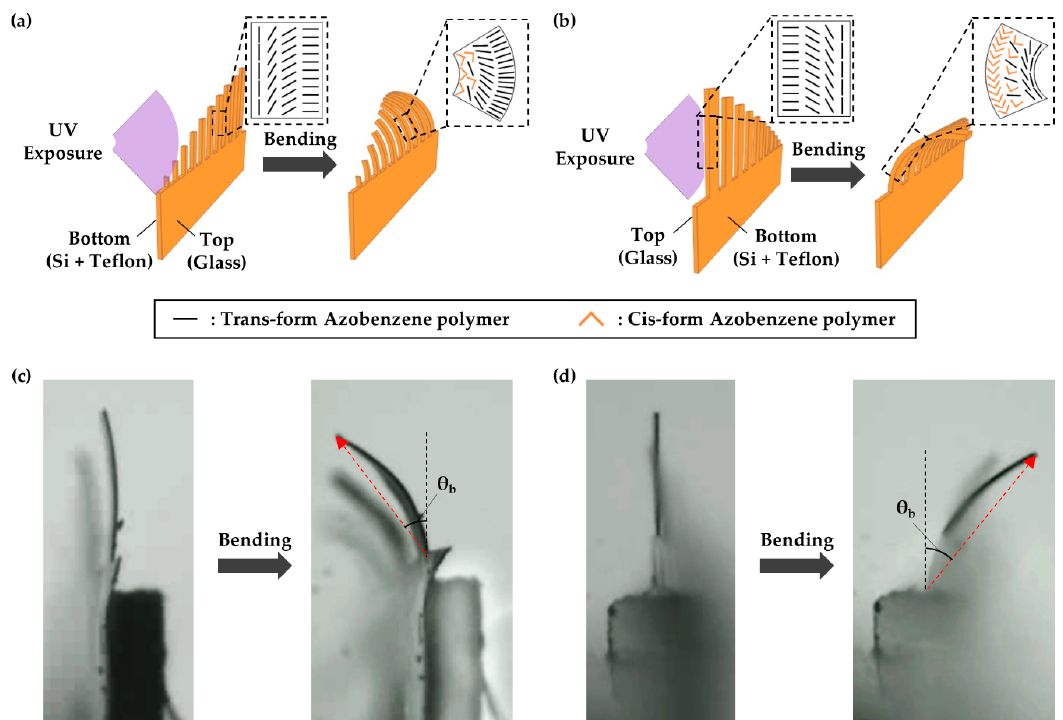
Figure 4. The relationship between the alignment of illuminated molecules and the bending direction by isomerization; the light exposure to ( a,c ) homogeneous and ( b,d ) homeotropic surfaces (depending on whether the surface faces the incident light, the bending direction could be the opposite).